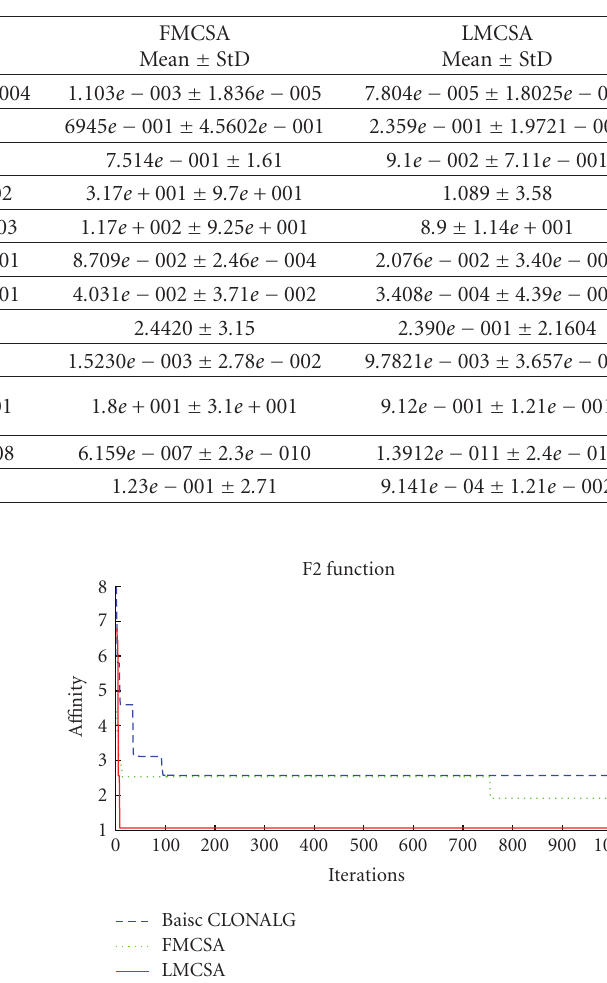
Table 2: Statistical means and standard deviations of the solutions of twelve Benchmark test functions, listed in Table 1 for the CLONALG, FMCSA, and the LMCSA.